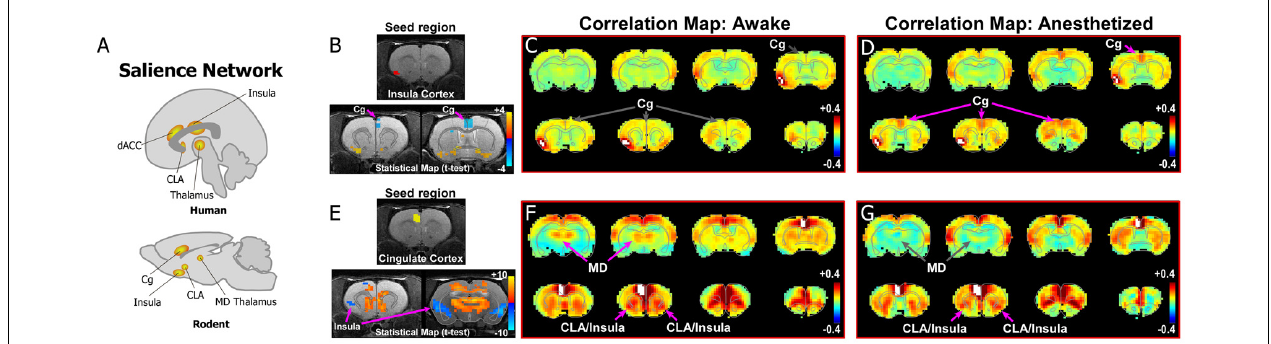
FIGURE 3 | Rodent homolog of the SN. (A) Diagrams illustrating the human and rodent SN. (B–D) Analysis of rs-fMRI in awake and anesthetized rats for an insular cortex seed. (B) Top panel shows location of insular cortex seed in a structural T1-MRI. Bottom panel shows statistical maps comparing the awake and anesthetized states (voxelwise two-way t -test), indicating an increase in correlation strength between insula and cingulate cortex (Cg) in the anesthetized state compared to the awake state (blue area identified by pink arrow). Color plot shows t -values for voxels with p < 0.05 (false discovery rate), in which cool colors indicate a significant increase in correlation under anesthesia compared to the awake state. (C) Correlation maps from rs-fMRI with seed-based correlation analysis of insula in the awake state reveal no functional connections with Cg cortex. Color plot indicates scale of correlation strength: hot colors are correlated, cool colors are anti-correlated. (D) Correlation maps from rs-fMRI with seed-based analysis of insula in the isoflurane anesthetized state show weak functional connections with Cg cortex. (E–G) Similar analyses of a Cg cortex seed show strong functional connections with CLA in the awake and anesthetized states. Cg cortex also showed strong functional connections to MD thalamus in the awake state that is significantly diminished in the anesthetized state, similar to mPFC shown in Figure 2 . Data modified with permission from Smith et al.